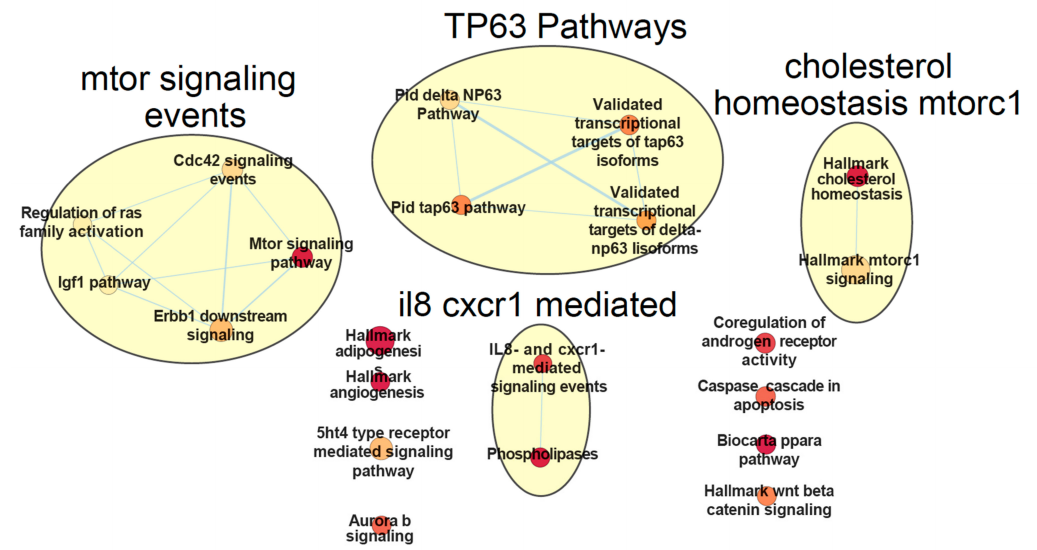
Figure 6. Top predictive features for not mutated IGHV CLL patients. Each node shows predictive pathway features and edges, which connect shared genes of pathways. Node fill uniformly indicates highest score; yellow = netDx score 3, red = netDx score 10. The size of the nodes displays the amount of genes in the underlying gene set. Selected features required a minimum feature score of 9 out of 10 in at least in 50% of train/test